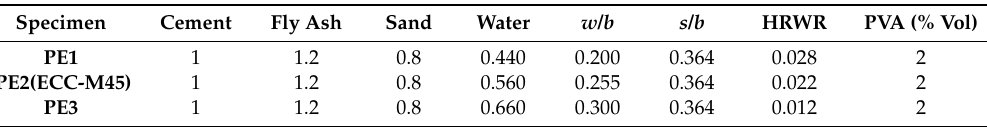
Table 2. Mix normalized proportions by weight of PVA-ECC specimens.